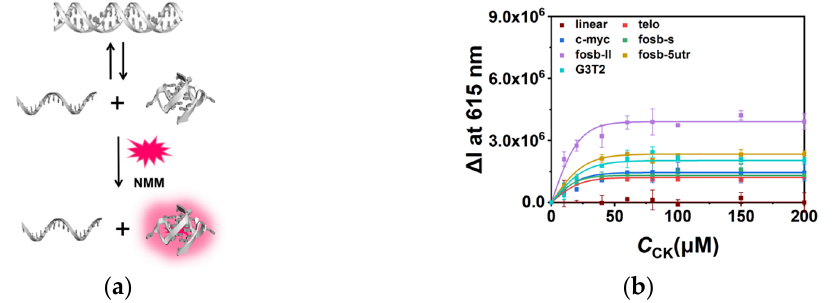
Figure 3. ( a ) The schematic demonstration of the equilibrium of duplex and G4-complementary sequence in the presence of fluorescence probe NMM. ( b ) The fluorescence intensity changes ( Δ I) at 615 nm of NMM in the presence of different concentrations of CK in a buffer containing 40 mM Tris-HCl (pH 7.6) and 8 mM MgCl 2 in the conditions with 10 mM K + .